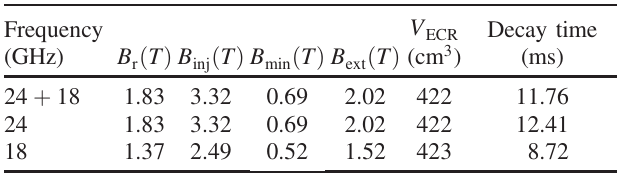
TABLE V. Comparison of key parameters of Xe 30 þ afterglow beams with different microwave frequencies. The volume en- closed by the cold electron resonance, V considering the resonance zone as a 3D ellipsoid surface and the microwave power is 1 kW for each